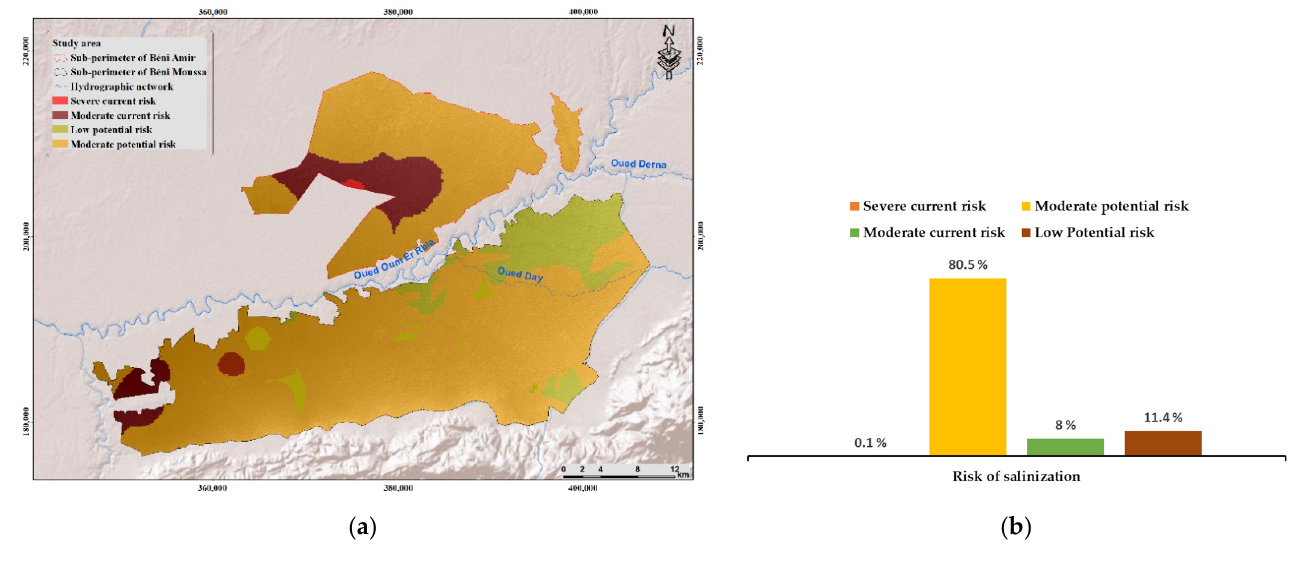
Figure 2. Soil salinization risk map ( a ) and Areas of risk classes ( b